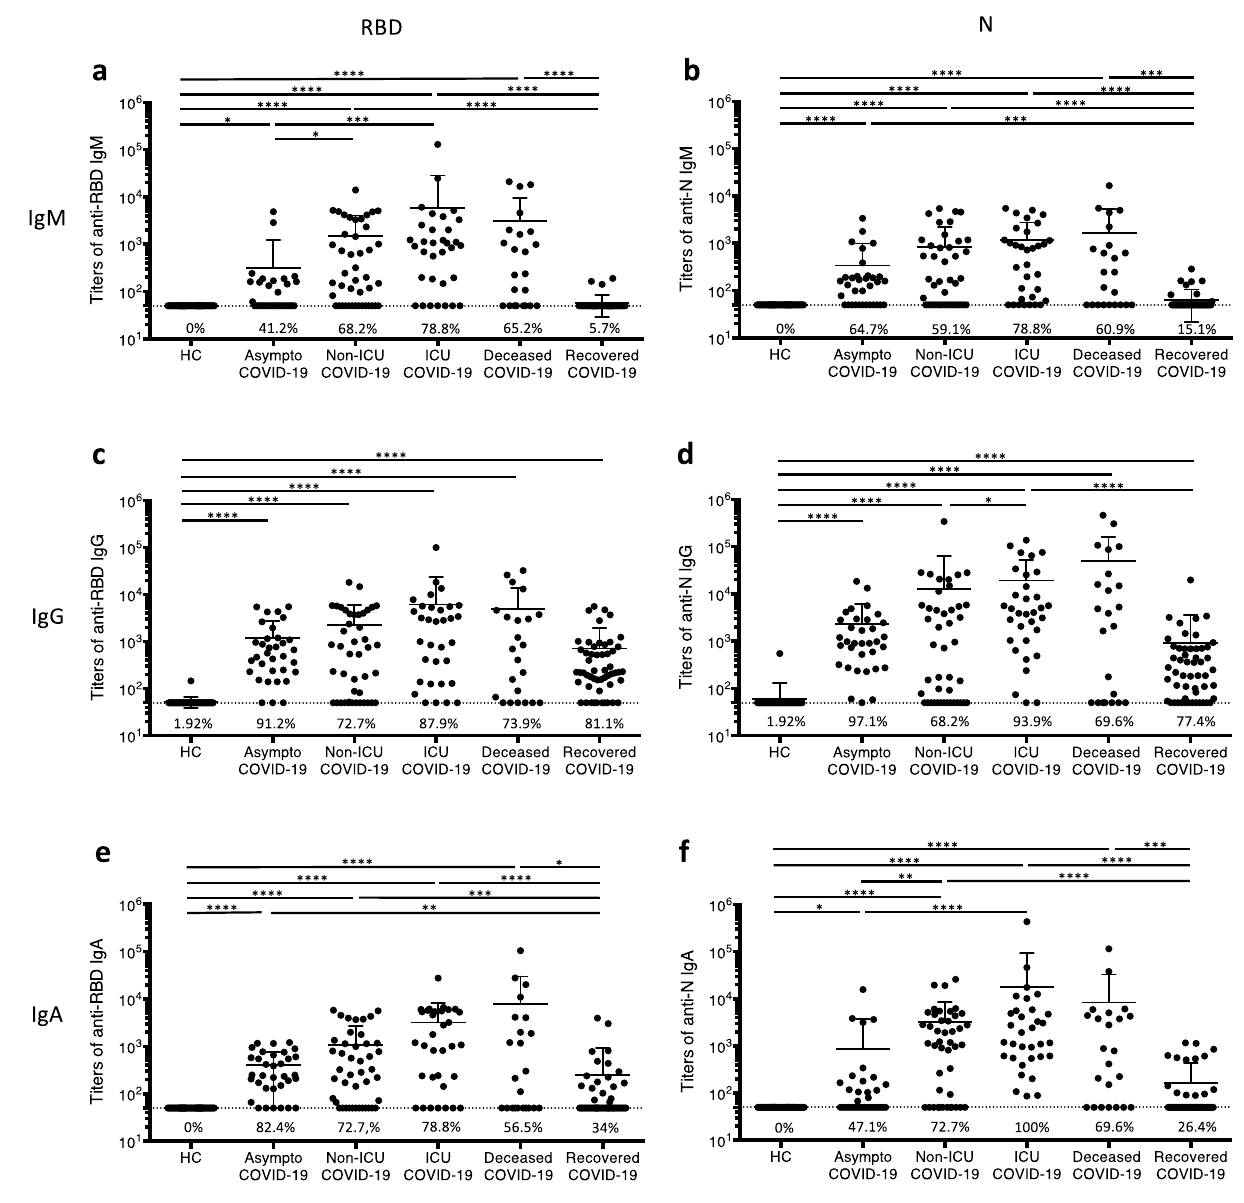
Figure 1. Antibody responses against SARS-CoV-2 in COVID-19 patients. Titers of IgM ( a , b ), IgG ( c , d ) and IgA ( e , f ) directed against RBD (left panels) or N (right panels) in serum or plasma of healthy controls and COVID-19 patients were determined by ELISA. The six patient cohorts are presented in Table 1. The percentage of positive samples is indicated. Samples were considered positive when antibody titer was greater than 50 (dashed line), the lowest dilution of serum/plasma tested. Each dot represents one sample. * p < 0.05, ** p < 0.01, *** p < 0.001, **** p < 0.0001 (Kruskal Wallis test and Dunn’s multiple comparisons